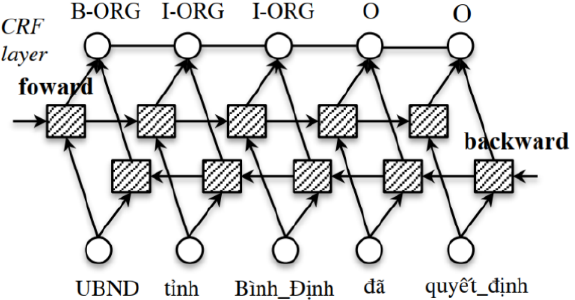
Fig. 1. Bi-LSTM+CRF architecture for a sample Vietnamese